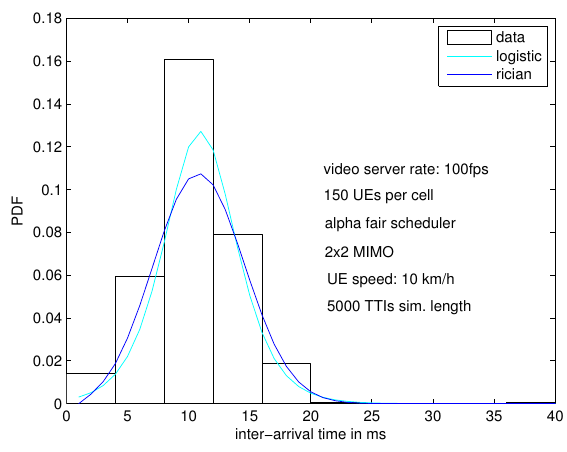
Figure 4: Probability density function of the inter- arrival times